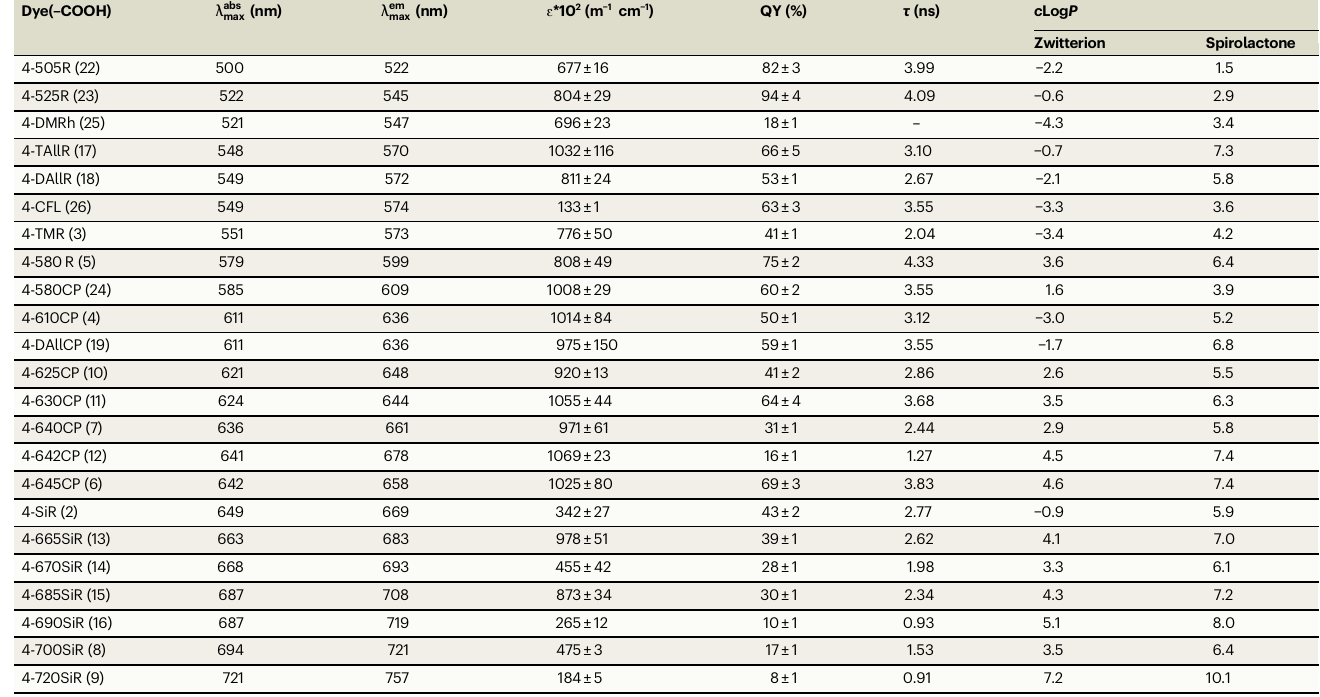
Data in thetable representthe mean±SD( N